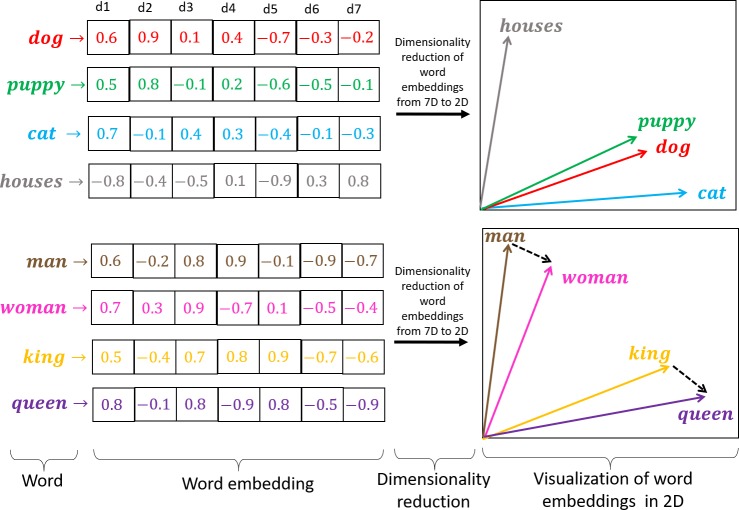
Word embeddings map words in a corpus of text to vector space.Linear combinations of dimensions in vector space correlate with the semantic and syntactic roles of the words in the corpus. For illustration purposes, dimension d1 in the figure has a high positive correlation with living beings. A properly tuned word embedding model will map words with similar semantic or syntactic roles to adjacent regions in vector space. This property can be visualized through dimensionality reduction techniques such as t-SNE or PCA (see upper right quadrant of the figure). Cultural concepts are also apparent in vector space as consistent offsets between vector representations of words sharing a particular relationship. For instance, in the bottom right of the figure, the dotted vector represents a gender regularity that goes from masculinity to femininity.